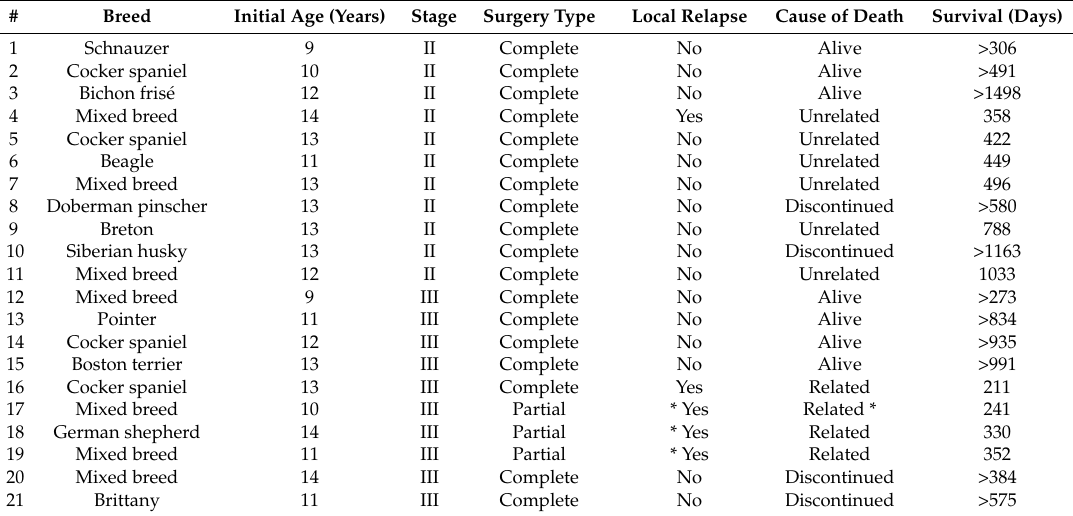
Table 1. Patient demographics, disease stages at study entry, and survival